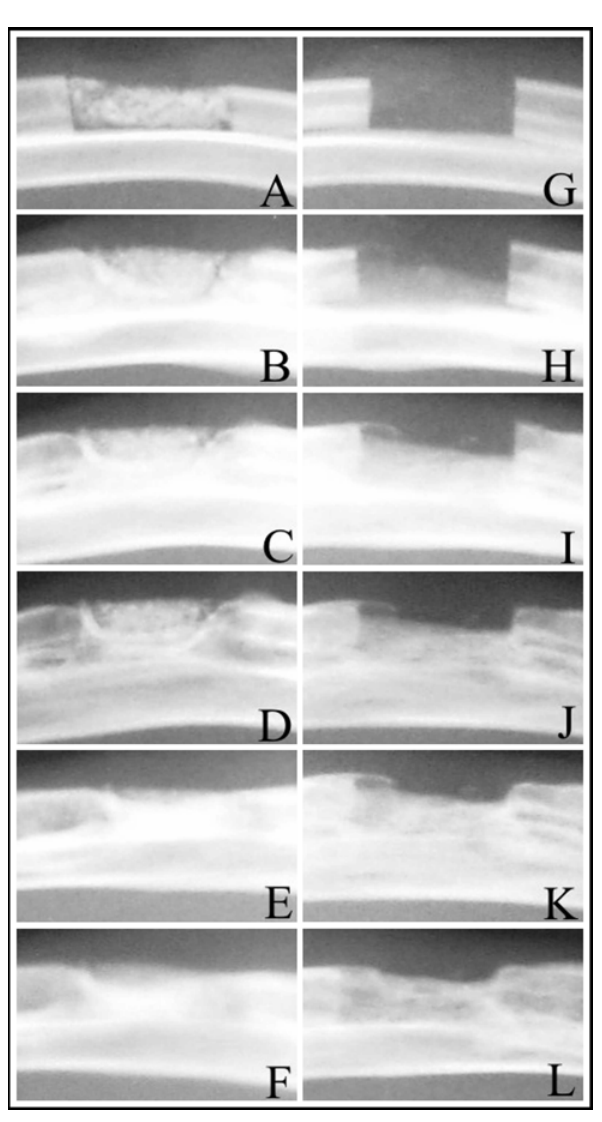
FIGURE 1 - Typical radiographic appearance of the defects of Group A, immediately after surgery (A) 30 (B), 60 (C), 90 (D), 120 (E), and 150 (F) days postoperatively; and of Group B, immediately after surgery (G), 30 (H), 60 (I), 90 (J), 120 (K), and 150 (L) days